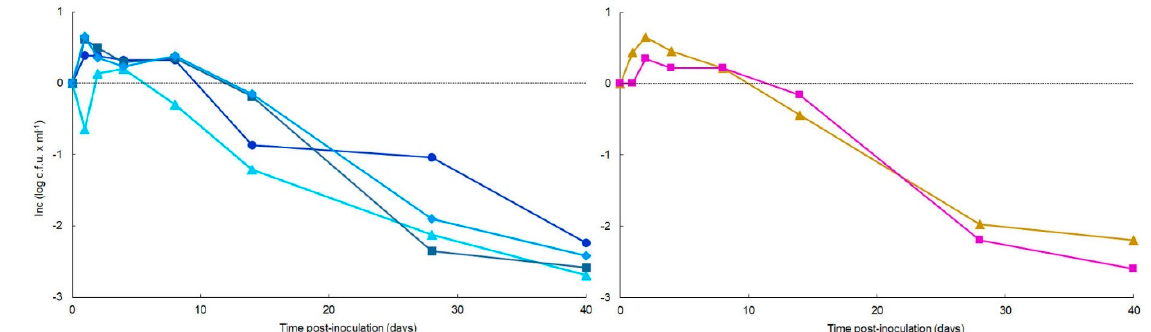
7 of 18 Figure 1. Effect of low temperature under nutrient-limiting conditions on survival of Ralstonia sola- nacearum strain IVIA-1602.1 during 40-day periods in water. Microcosms of: EW − 4, environmental water at 4 °C; DW − 4, distilled water at 4 °C; EW − 24, environmental water at 24 °C, and DW − 24, distilled water at 24 °C. Total ( ■ ), viable ( ● ), and culturable cells on SMSA ( ▲ ) and YPGA ( ♦ ) media. Data from one representative environmental water sample have been plotted. Points are mean ± standard deviation of triplicate microcosms.